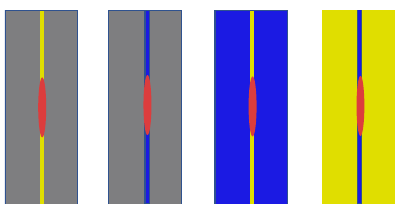
Figure 10. Color constancy affected by surrounding colors. All centering objects have the same color value (pink), but their appearances differ.